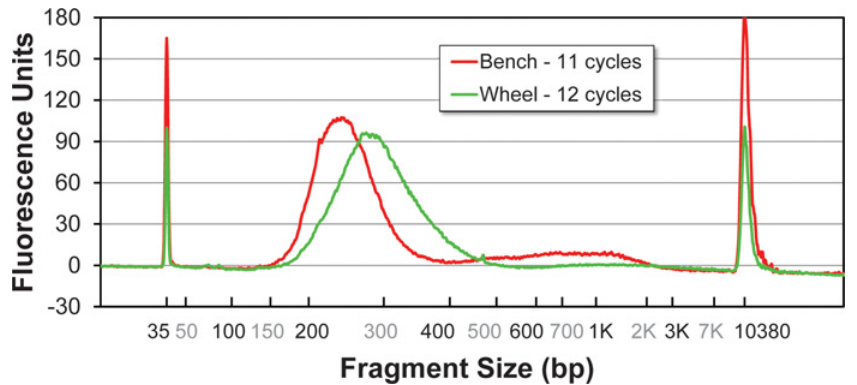
Fig 14. BioAnalyzer data from analysis of second-strand cDNA products generated by the bench-top and rzPCR systems. Note that rzPCR reactions were run for an additional cycle (12 cycles total, as compared to 11 cycles for the bench-top